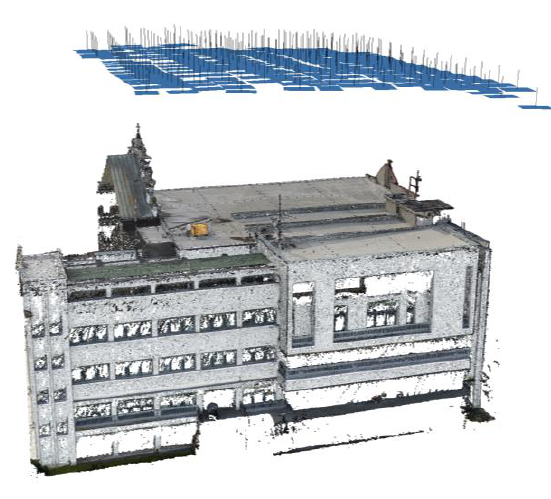
Figure 3 . Image position with point